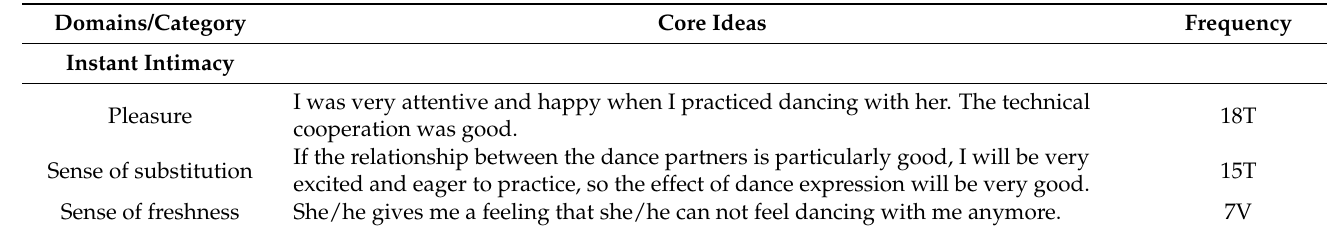
Table 3. Domains and